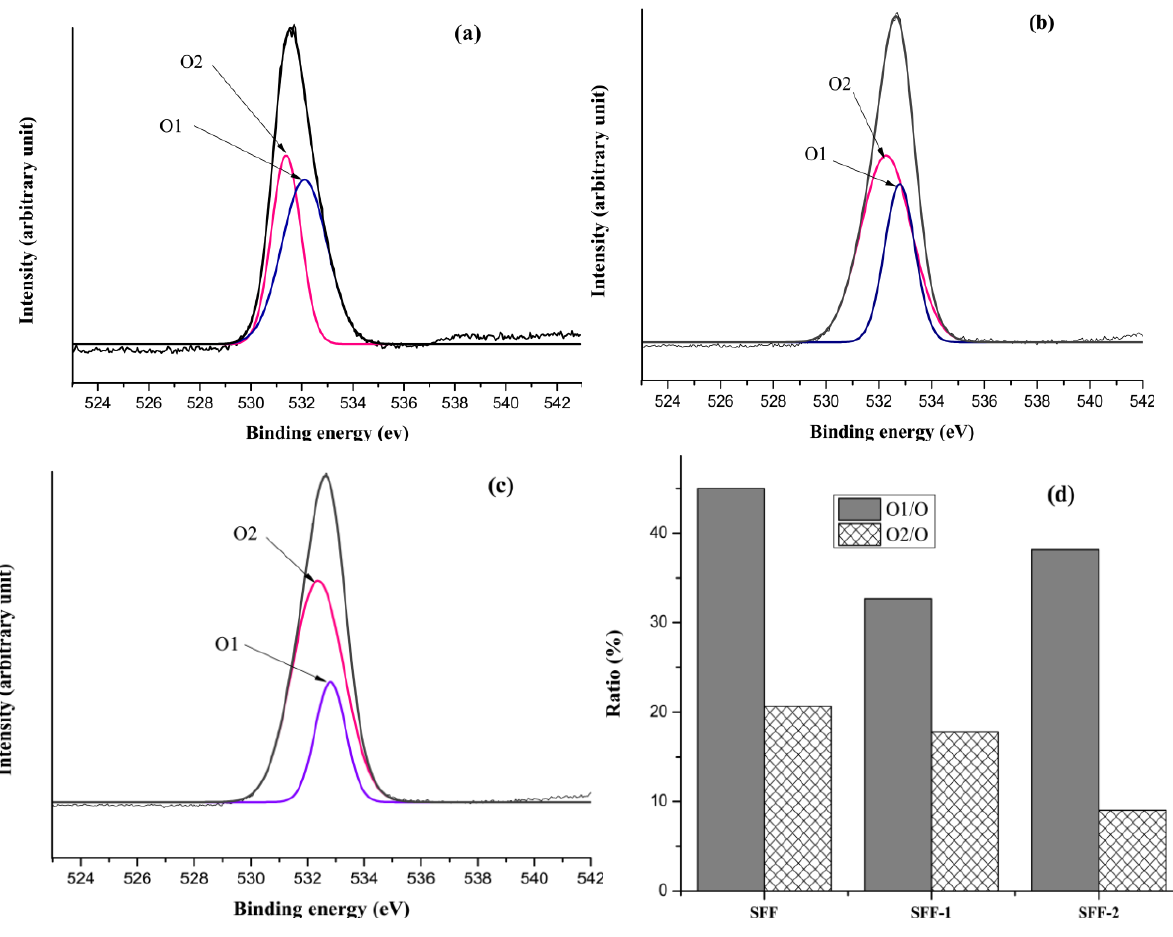
Figure 9. XPS spectra of O 1s peaks ( a ) SFF; ( b ) SFF-1; ( c ) SFF-2 and ( d )